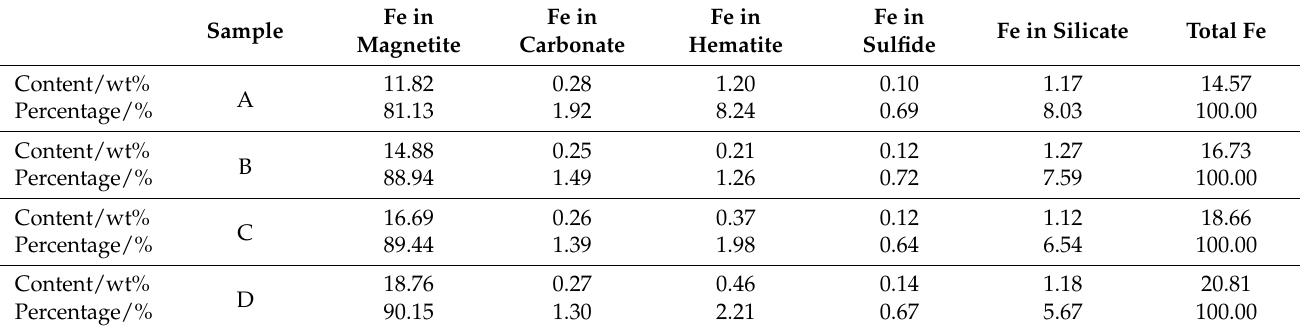
Table 5. The iron phase compositions and the content of Fe in iron phase of sample A to D after magnetization